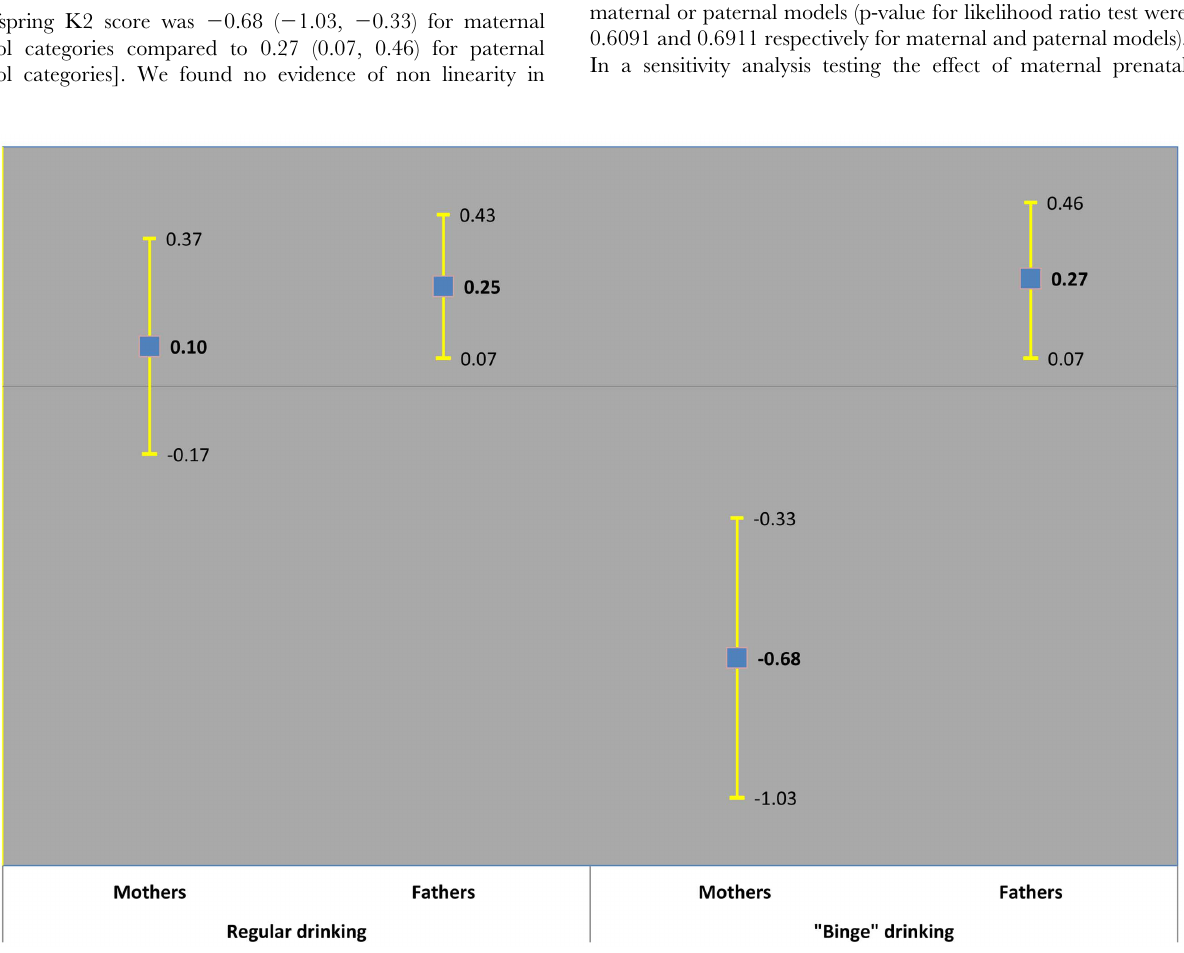
Figure 1. Mean change in offspring KS2 score per increase in maternal and paternal alcohol categories. Adjusted for sex, maternal age, parity, socio-economic position, ethnicity, maternal and paternal education and smoking and other parent’s alcohol consumption.